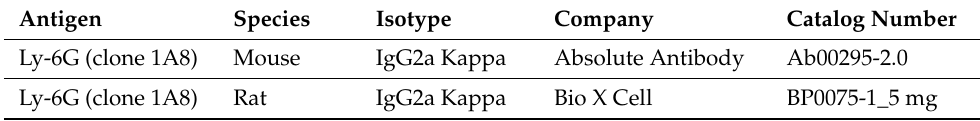
Table 1. Antibodies used to deplete neutrophils.